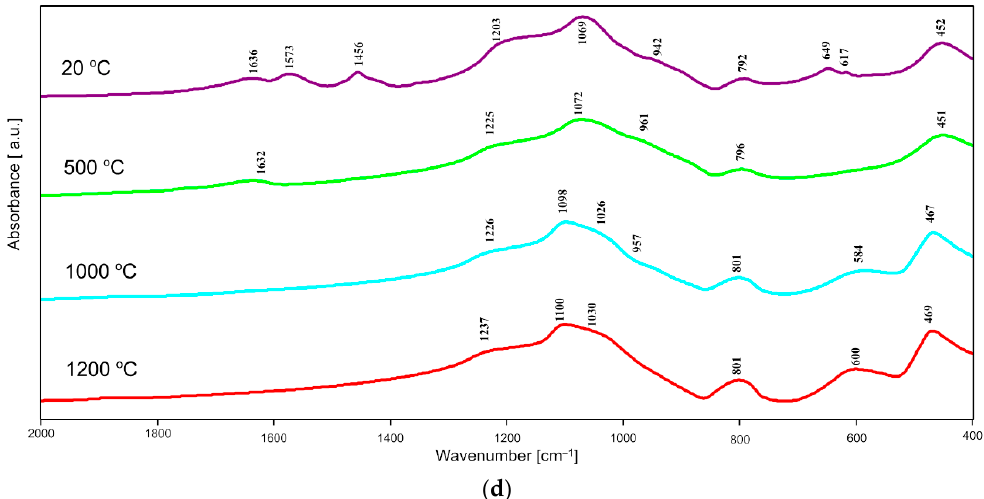
Figure 5. FTIR spectra of: ( a ) 1T sample; ( b ) 2T sample; ( c ) 3T sample and ( d ) 4T sample. All samples were synthesized using zirconium (IV) n-propoxide and annealed at 500 °C, 1000 °C and 1200 °C in the air.